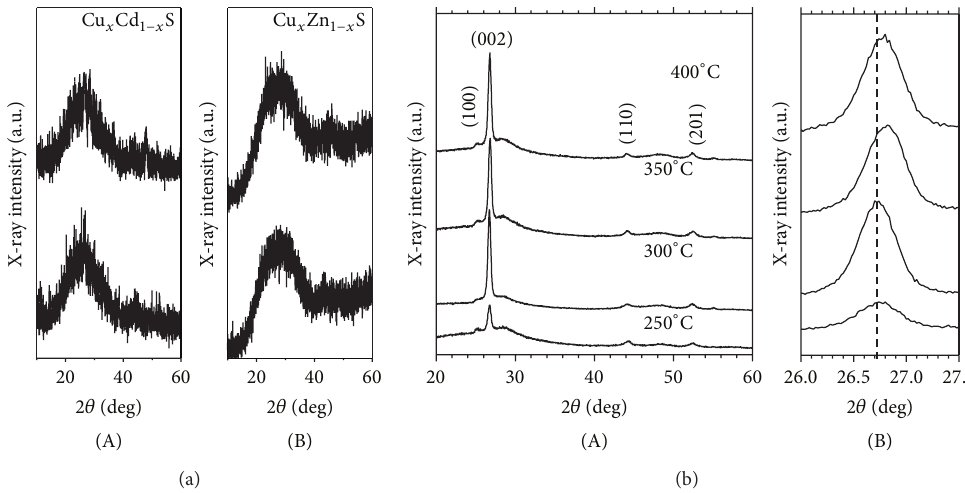
Figure 2: (a) X-ray diffraction patterns of the ternary semiconductor compounds annealed at 250 ∘ C (bottom patterns) and 450 ∘ C (top patterns) of (A) Cu 𝑥 Cd 1−𝑥 S and (B) Cu 𝑥 Zn 1−𝑥 S. (b) X-ray diffraction patterns of the ternary semiconductor compounds of Zn 𝑥 Cd 1−𝑥 S,